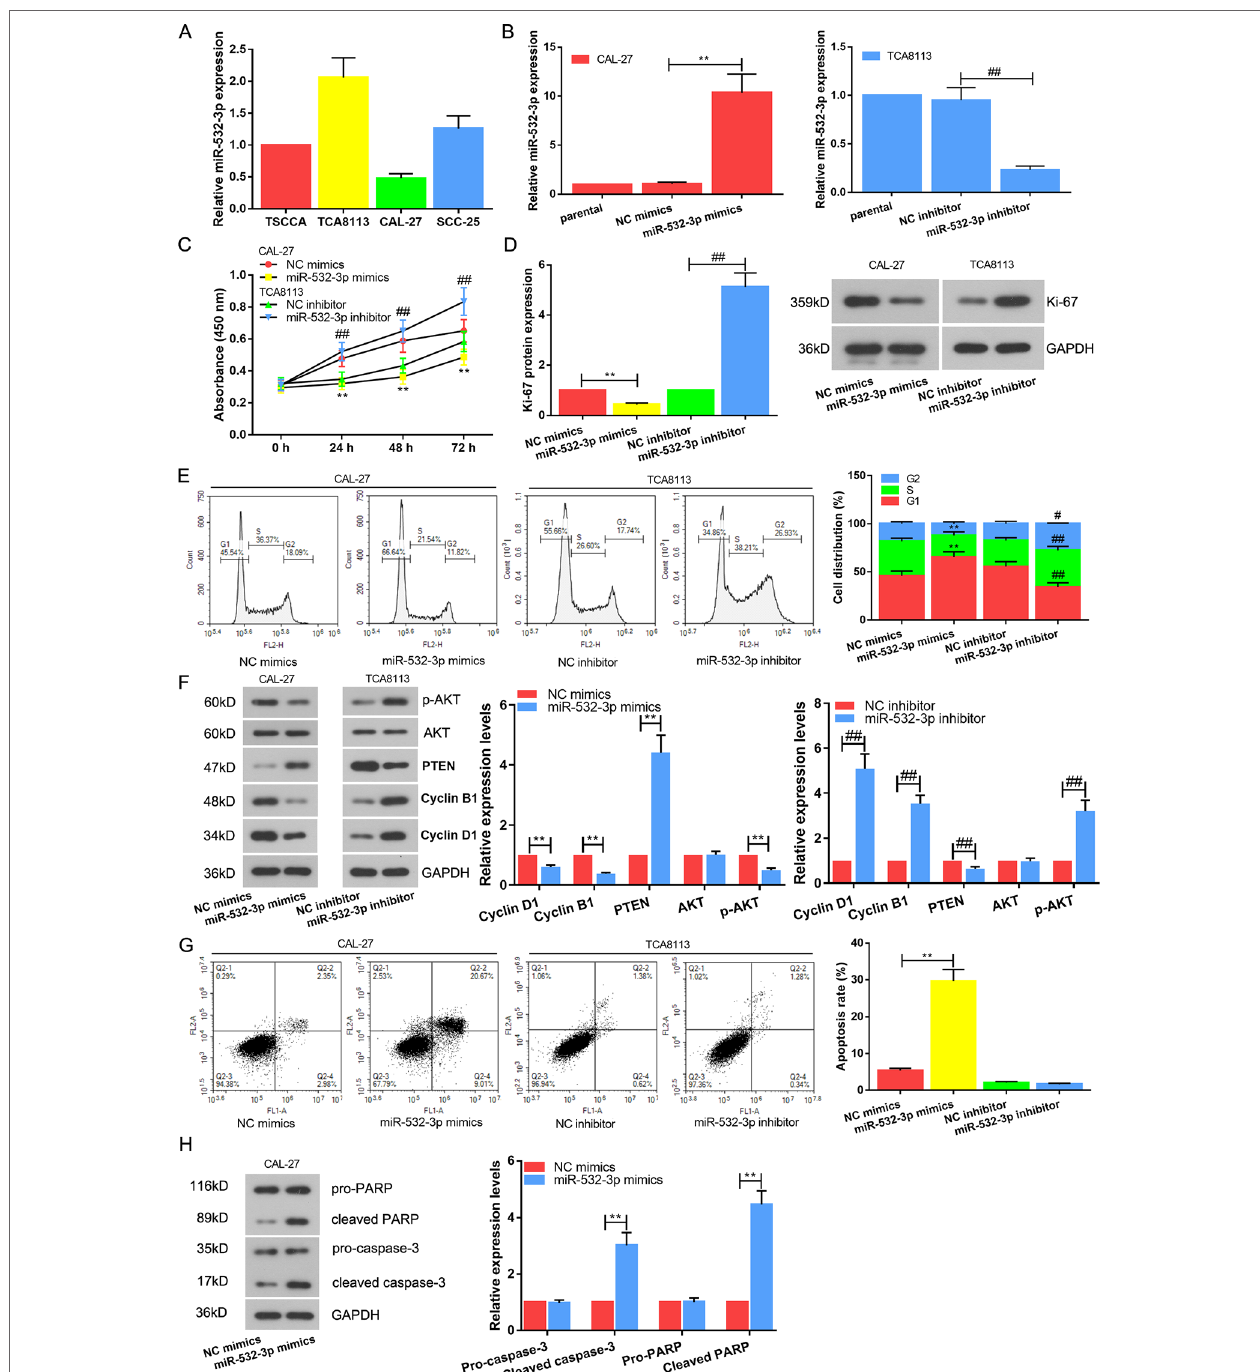
FIGURE 2 | Overexpression of miR-532-3p inhibits cell proliferation and facilitates apoptosis in TSCC. (A) Expression of miR-532-3p was detected via real-time PCR in four types of TC cells, TSCCA, TCA8113, CAL-27, and SCC-25. Relatively highest and lowest miR-532-3p expression were in TCA8113 and CAL-27 cells, respectively. (B) Expression of miR-532-3p was increased after transfection miR-532-3p mimics in CAL-27 cell. When TCA8113 was transfected with miR-532-3p inhibitor, the expression of miR-532-3p was decreased. Cell proliferation was measured using CCk-8 assay (C) , Ki-67 protein expression analysis (D) and cell cycle detection (E, F) . (G) Promotion of apoptosis by overexpression of miR-532-3p. TCA8113 and CAL-27 cells were transfected for 48 h and apoptotic cells were monitored with flow cytometry after Annexin V and PI staining (H) . Apoptosis-related proteins (caspase-3 and PARP) were tested by western blot. **p < 0.01 vs. miR-532-3p mimics; #p < 0.05, ##p < 0.01 vs. miR-532-3p